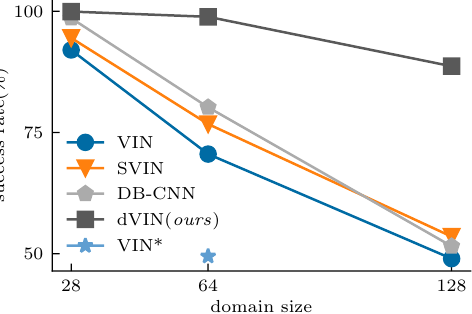
Figure 1. Success rate in test set vs. domain size. Our dVIN outperforms three baseline methods on the grid-world path planning task, especially on large-size domains. VIN* is trained from scratch in 64 64 domains. Additionally, its performance is much lower than that of the VIN trained with the × two-stage training